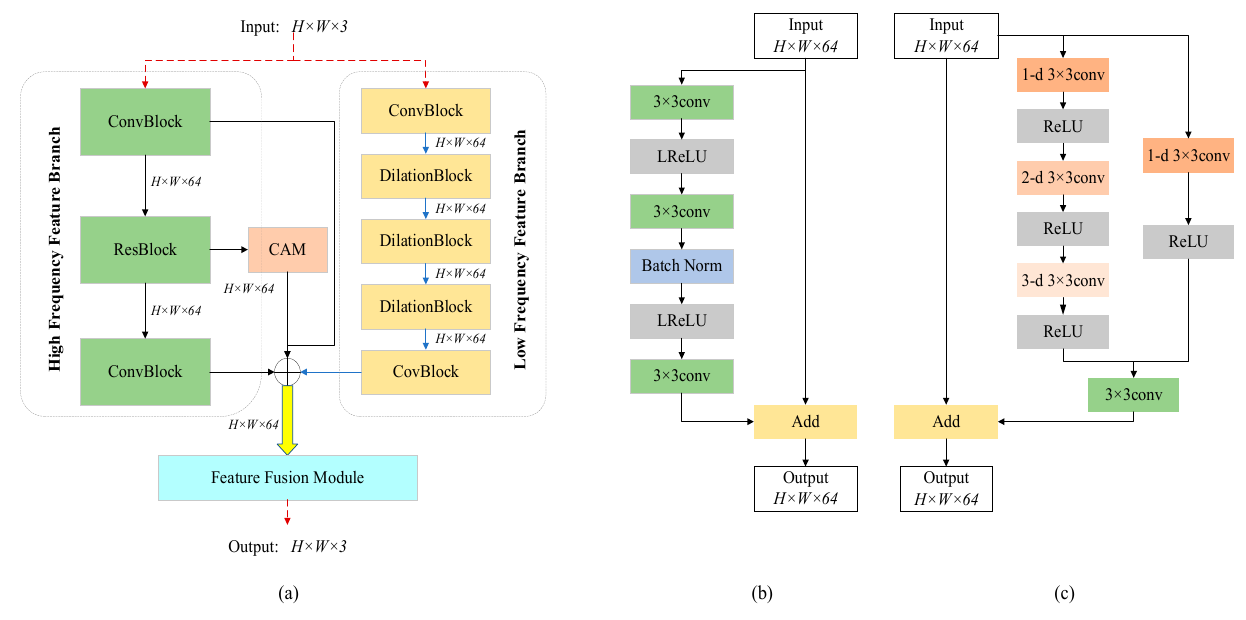
Figure 2. Structure of proposed bilateral feature enhancement module. ( a ) Details of bilateral feature enhancement module which consists of high frequency feature branch and low frequency feature branch. ( b ) Details of ResBlock. ( c ) Details of DilationBlock.